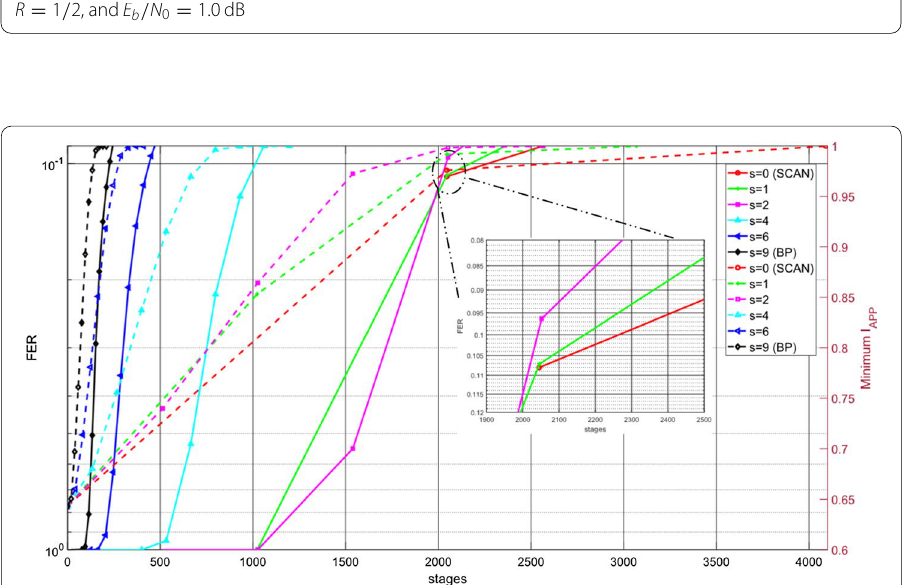
Fig. 6 FER and convergence behavior of the minimum I APP using different decoding scheduling for N 1024 with code rate R 1 / 2 . The polar code is constructed using Gaussian approximation optimized for = = E b / N 0 2.0 dB (FER : solid line, Minimum I APP : dashed =